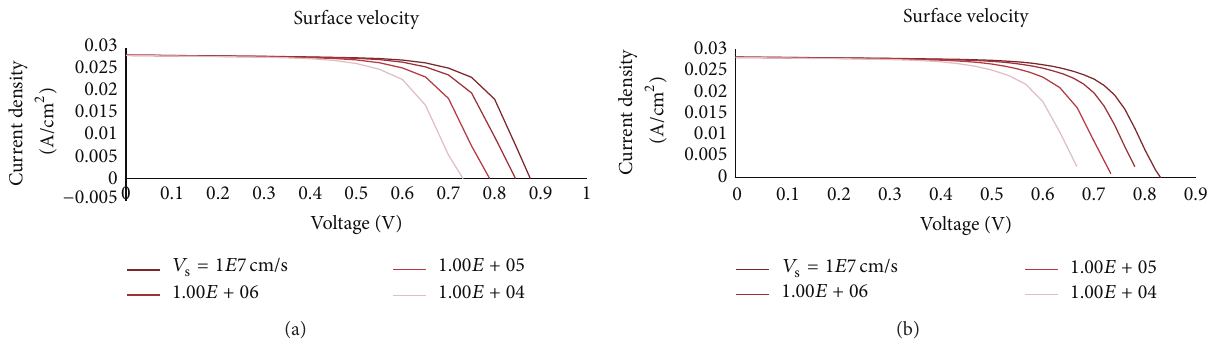
Figure 6: Effect of surface recombination velocity at back contact on cell performance. An ER thickness of 100nm and a doping density of 7 × 10 18 cm −3 are assumed; (a) barrier height of 0.1eV; (b) barrier height of 0.4 eV.